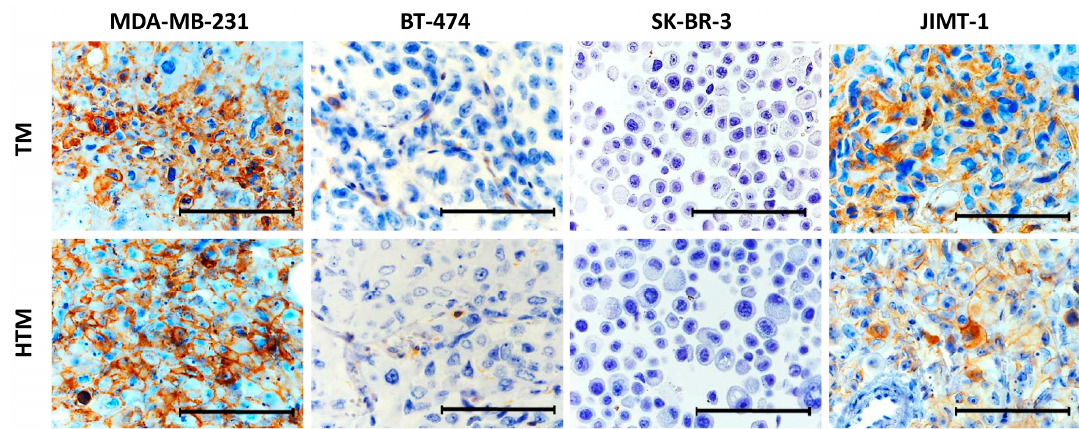
Figure 2. In vivo PD-L1 expression in tumors of tumor mice (TM) and humanized tumor mice (HTM), transplanted with different BC cell lines. Immunohistochemical staining of PD-L1 in tumor samples of TM or HTM transplanted with MDA-MB-231, BT-474, SK-BR-3 or JIMT-1 BC cell lines cotransplanted with or without human hematopoietic stem cells (HSC). Bars represent 100 µm.